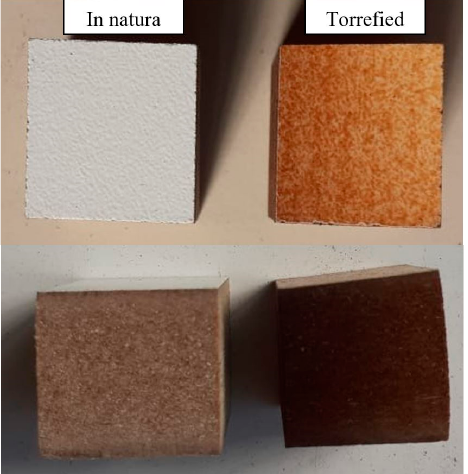
Figure 1. Sample of MDF untreated and after torrefaction (40 min). 2.2. Chemical Characterization The behavior during the combustion of untreated and torrefied samples was carried out through a thermogravimetric analysis, using a DTG60H simultaneous measuring instrument (Shimadzu, Kyoto, Japan) under a nitrogen atmosphere, following the norms of the American Society for Testing and Materials. The samples of 2 g of material were degraded, with an initial temperature of 100 °C and a final temperature of 600 °C, with a 10 °C/min − 1 heating rate. Additional chemical analysis of all treatments (Table 1) are available in the article of de Castro et al. [30]. The rate of biodeterioration by fungi is related to the chemistry of the material; Table 1 helps explain the results. Table 1. Residue properties of untreated MDF and after torrefaction for 20, 30 and 40 min used in the test to evaluate damage by xylophage fungi. Properties